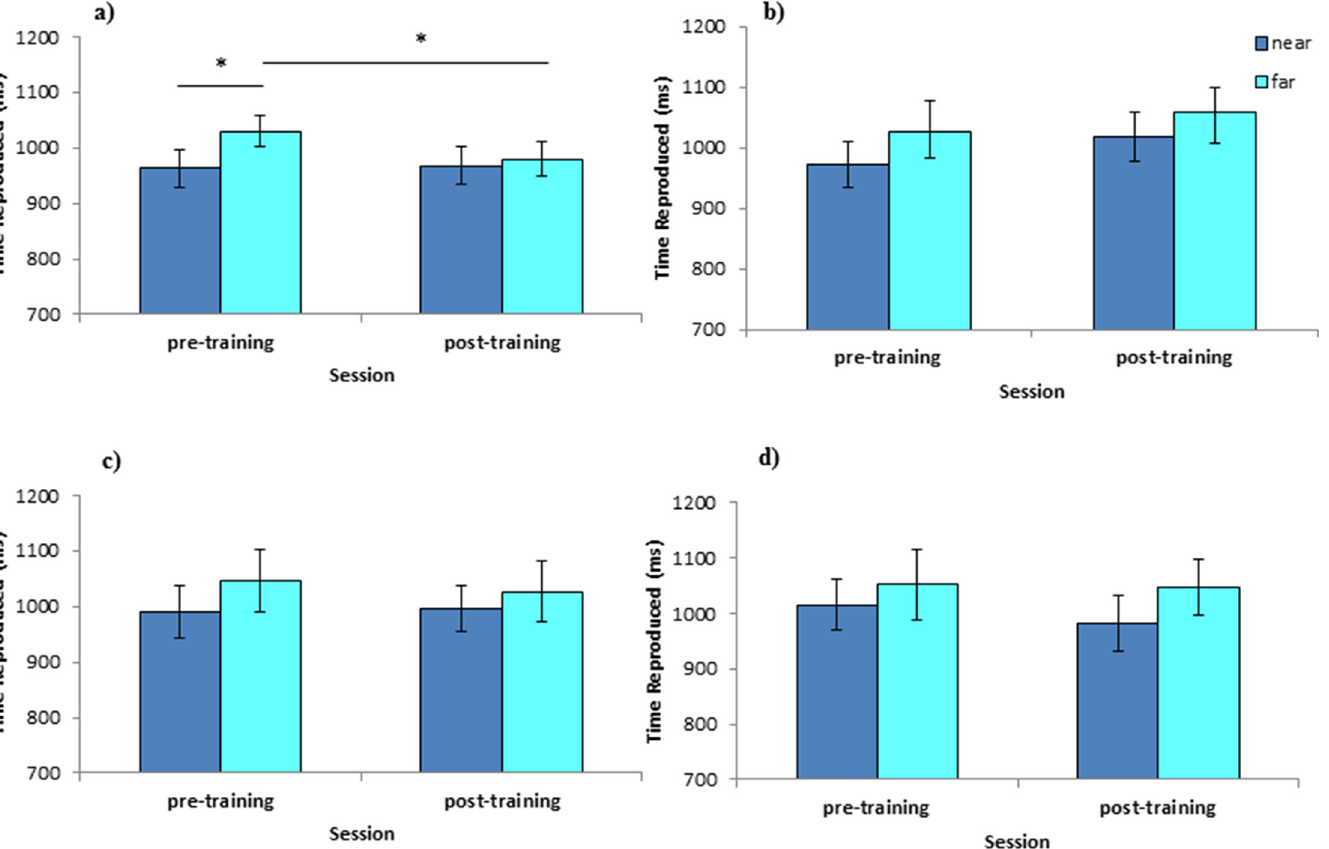
Fig 3. Space x Session interaction in the four experiments (Experiments 1 – 4 in panels a-d respectively). Values are in ms and error bars depicted SEM. Asterisks indicate significant differences (p < .05). Note that Space x Session interaction is not significant in Experiments 2 – 4, thus asterisks are not